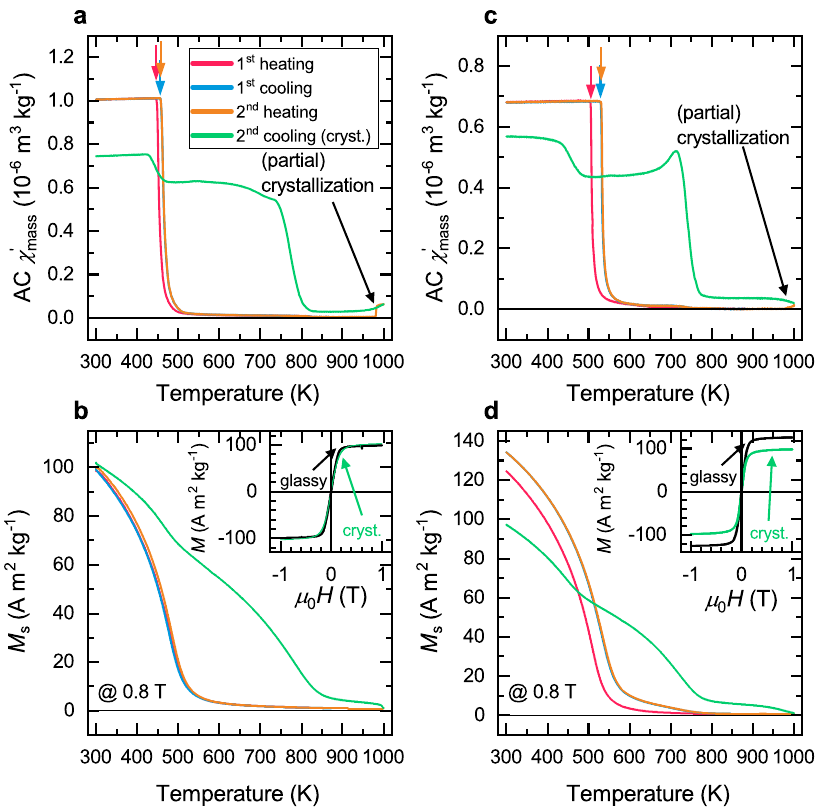
Fig. 4 Thermomagnetic curves and magnetic hysteresis of QNb and QMo. The AC susceptibility of a QNb and c QMo shows a clear transition from the ferromagnetic to the paramagnetic state (marked with arrows). The saturation magnetization as a function of temperature is shown in b for QNb and d for QMo. The hysteresis curves at 300 K for QNb and QMo are shown in the